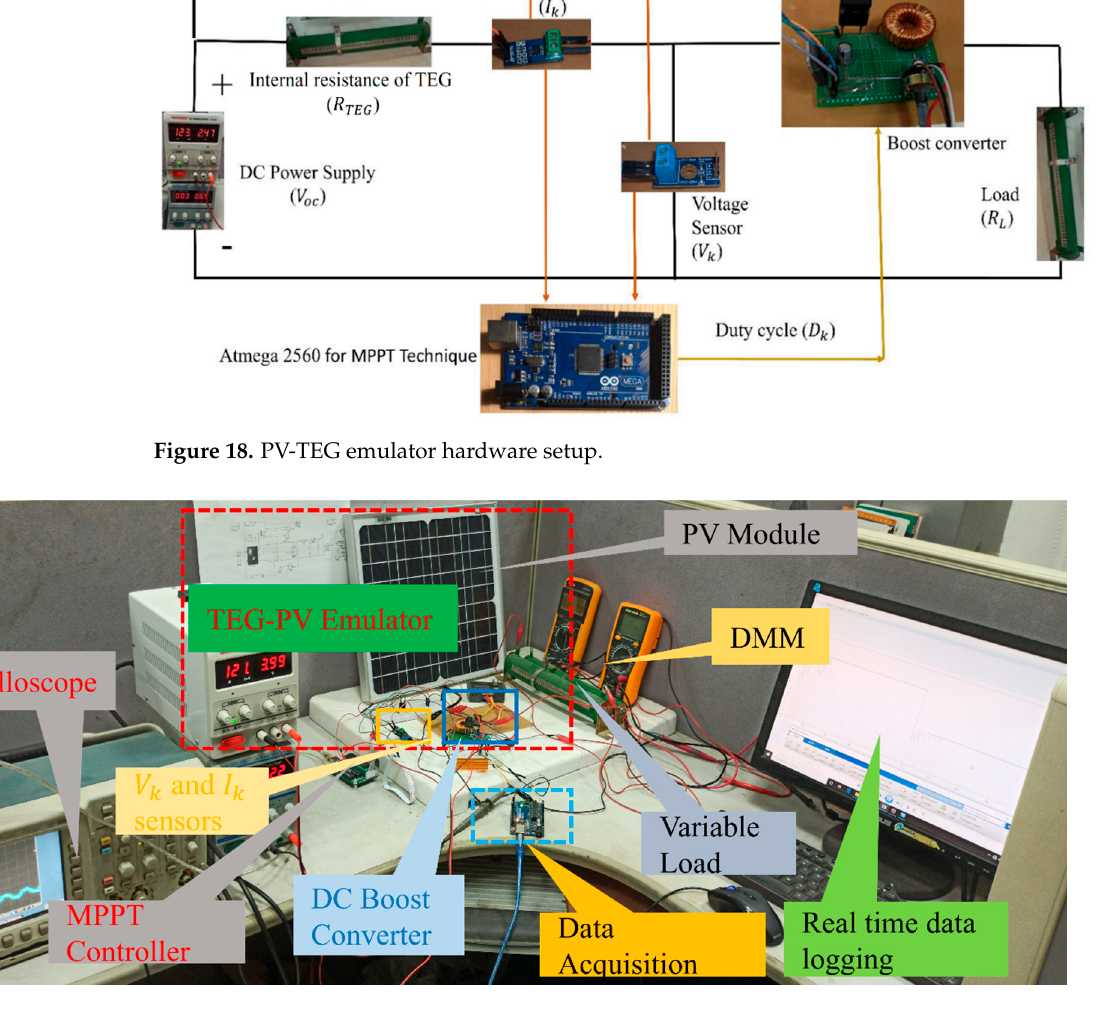
Figure 19. PV-TEG emulator hardware setup.